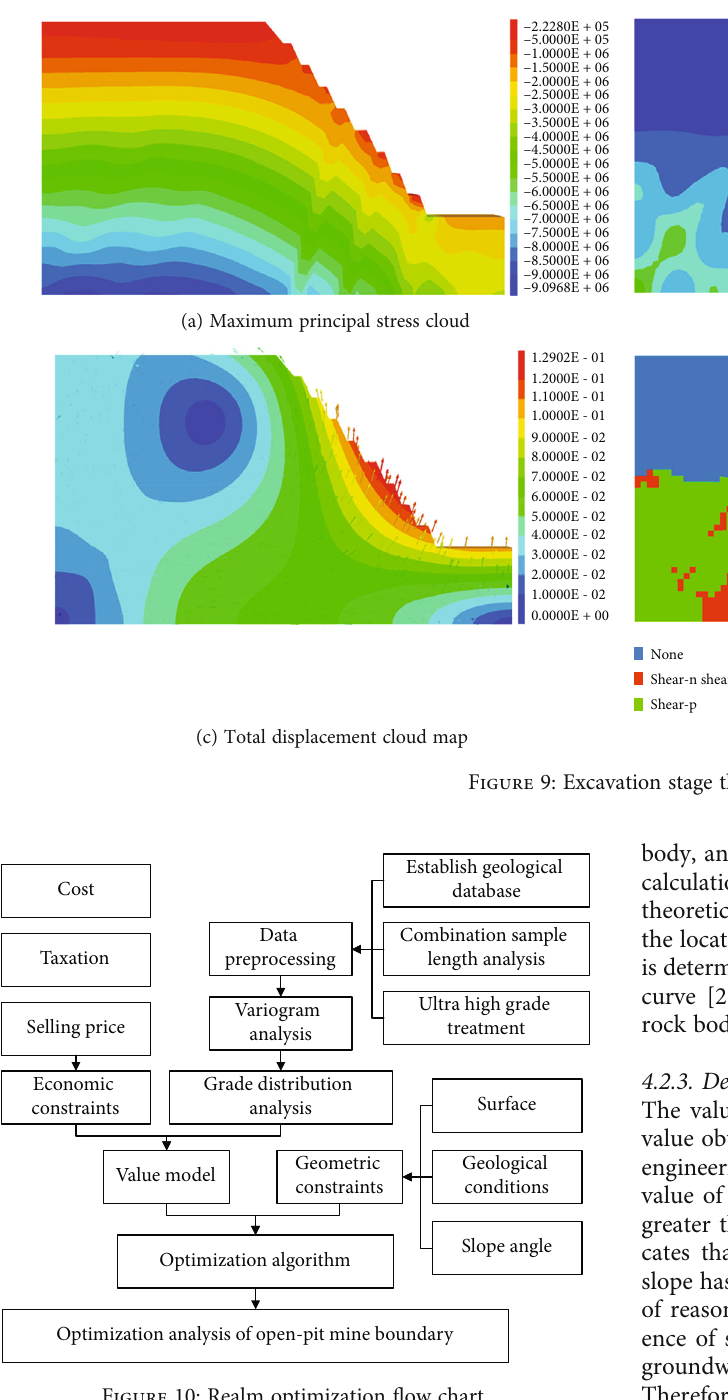
Figure 10: Realm optimization fl ow